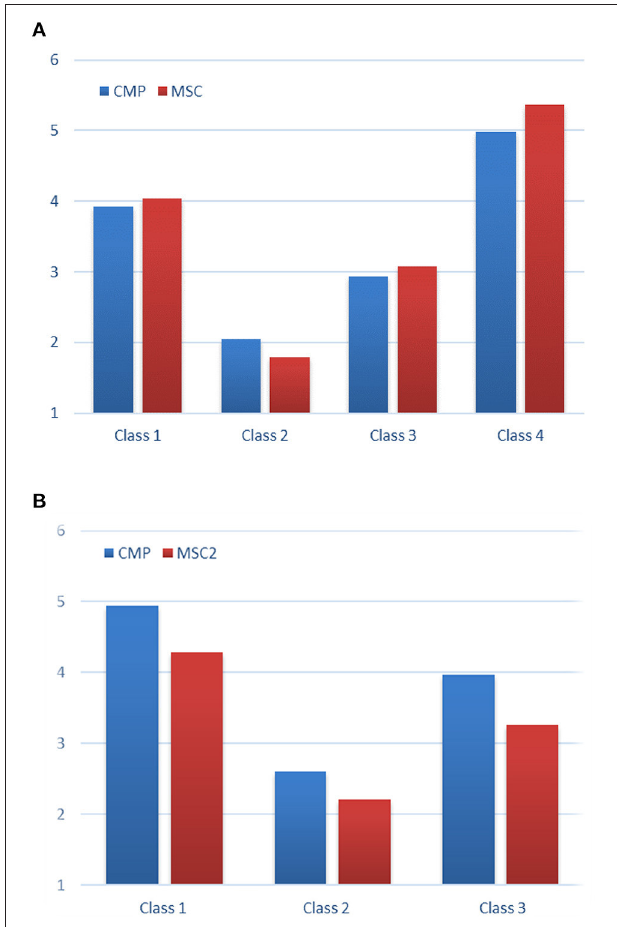
FIGURE 1 | Latent class factor analysis profile. (A) The Japanese sample ( n = 234). The estimated class percentages are Class 1 ( n = 131, 56.0%), Class 2 ( n = 21, 9.0%), Class 3 ( n = 48, 20.5%), Class 4 ( n = 34, 14.5%). (B) The Singaporean sample ( n = 328). The estimated class percentages are Class 1 ( n = 127, 38.7%), Class 2 ( n = 28, 8.5%), Class 3 ( n = 173, 52.7%). CMP, conscious motor processing; MS-C, movement self-consciousness. The x -axis lists the identified four classes and the y-axis shows the item-average scores of CMP and MS-C.